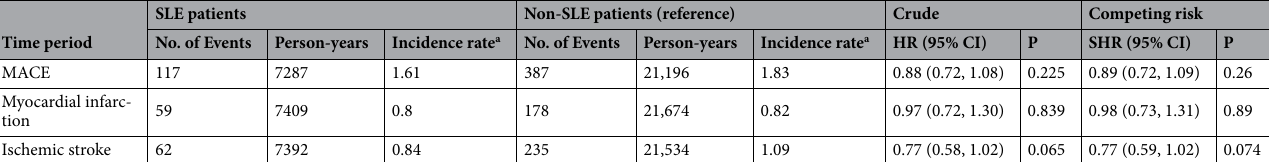
Table 6. Incidence rates and risks of MACE in SLE and non-SLE patients. MACE major cardiovascular events, AVF arteriovenous fistula, AVG arteriovenous graft, SLE systemic lupus erythematosus, HR hazard ratio, SHR subdistribution hazard ratio, CI confidence interval. a Per 100